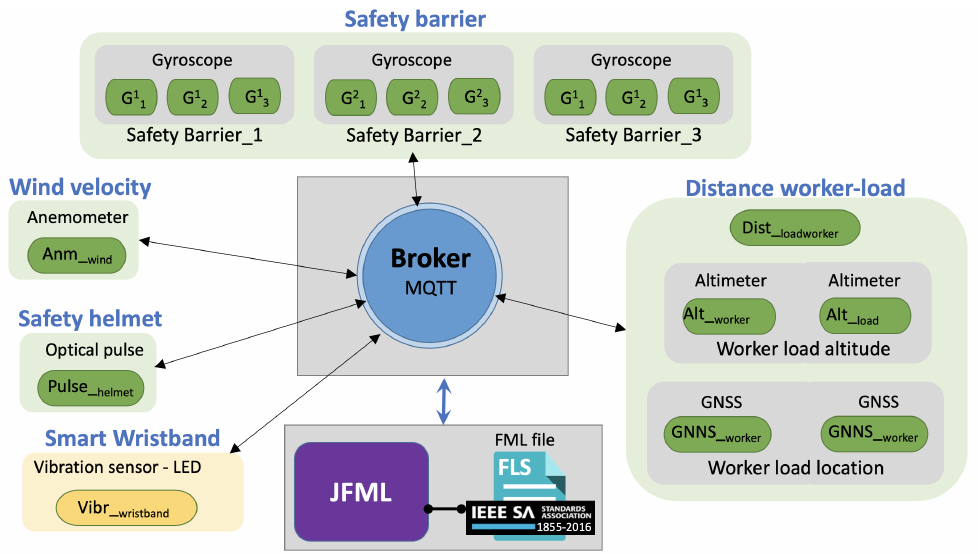
Figure 1. IOT-JFML